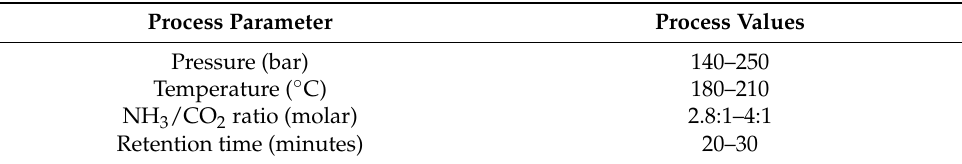
Table 1. Typical process parameters of urea production